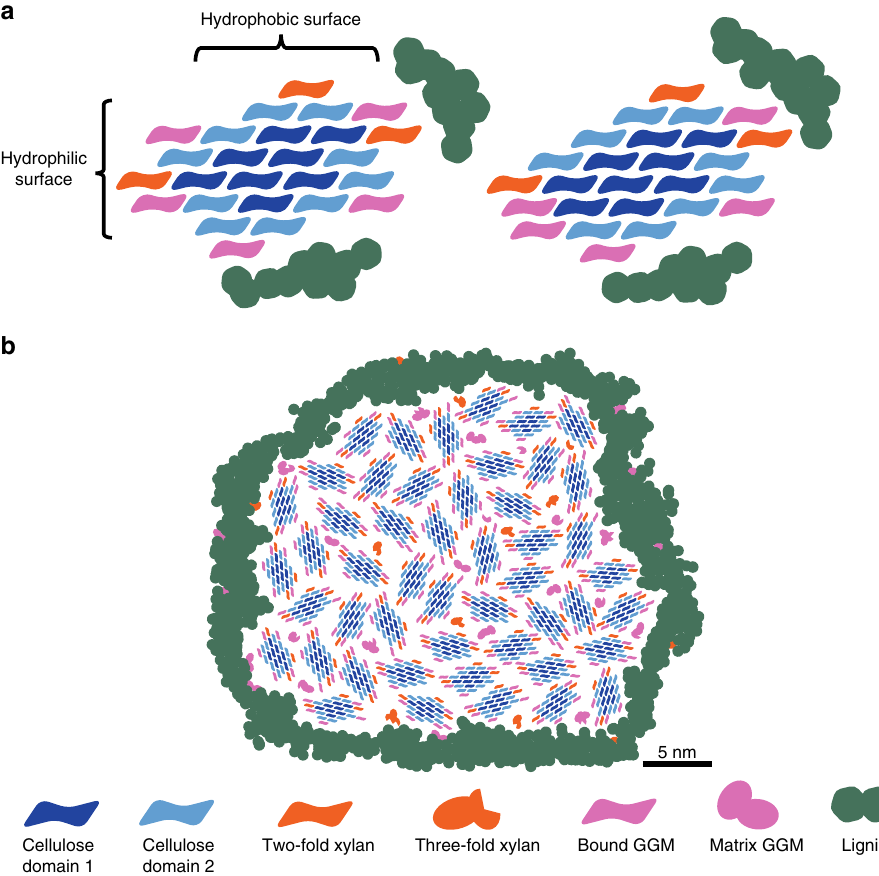
Fig. 6 a Possible models of the molecular architecture of softwood. The ratio of polysaccharide chains is based on the integrals of carbon 4 – 6 (carbon 4 – 5 for xylan) cross-peaks in the 30 ms CP-PDSD MAS NMR spectrum (see Fig. 2b) and the monosaccharide analysis. Both acetylated and unacetylated GGM are quanti fi ed together, as are the sub-domains of cellulose 1A – C and 2A – C. On the left, only xylan is shown as being able to convert domain 2 (C4 ≈ 84 ppm) to domain 1 (C4 ≈ 89 ppm) upon binding to the hydrophilic surface of the micro fi bril. On the right, binding of both xylan and some GGM to the hydrophilic surface can change domain 2 to domain 1. Lignin is shown mostly associated with itself, but is close to GGM, xylan and domain 2 cellulose. The cellulose micro fi brils are taken to have 18 glucan chains with a 2, 3, 4, 4, 3, 2 habit to match the measured cellulose domain 1 to domain 2 ratio upon xylan binding. b Model of spruce cell wall macro fi bril. Groups of cellulose micro fi brils with bound GGM and xylan form macro fi brils in spruce cell walls. In addition to cellulose-bound xylan and GGM macro fi brils may contain some three-fold xylan and matrix GGM. Lignin is localised to the surface of the polysaccharide core of the macro fi bril and interacts predominantly with GGM, xylan and cellulose domain 2. Size bar (5 nm) is provided for Fig. 6b) and is based on measurements presented in the literature 11,